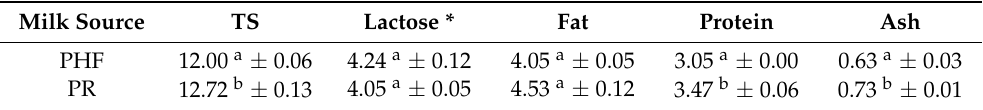
Table 1. Basic chemical composition of milk used for cheese production (g/100 g, average ± SE, n = 4).